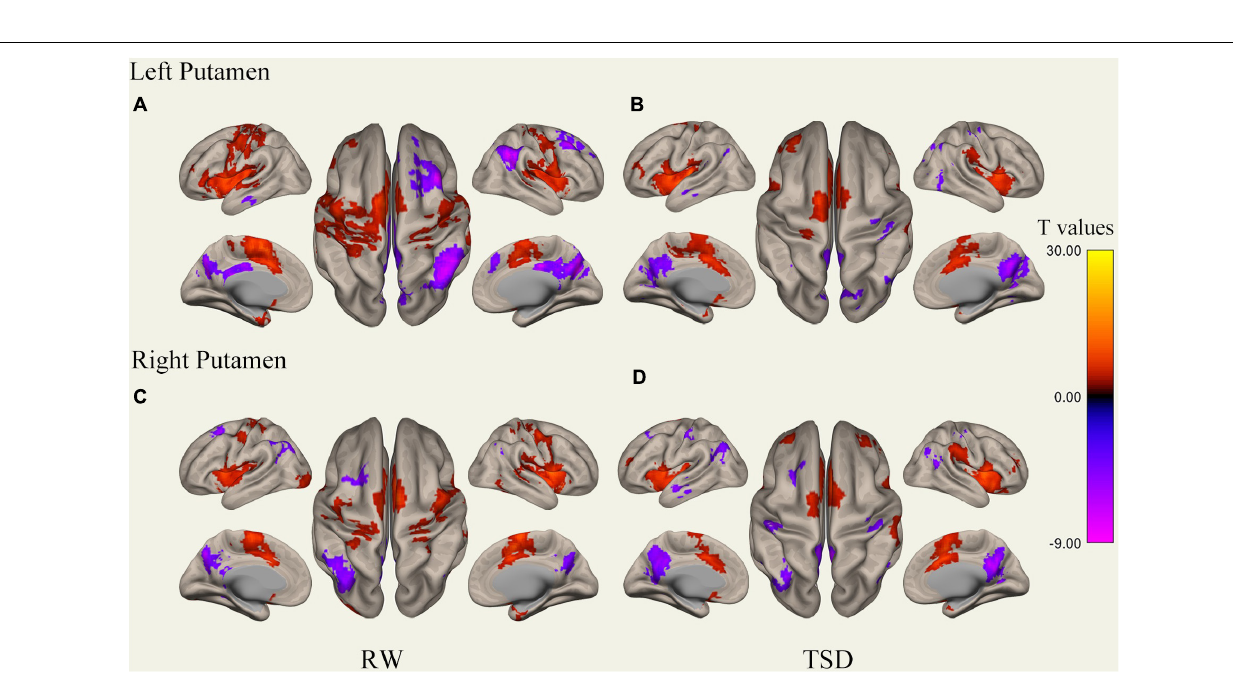
Frontiers in Neuroscience |